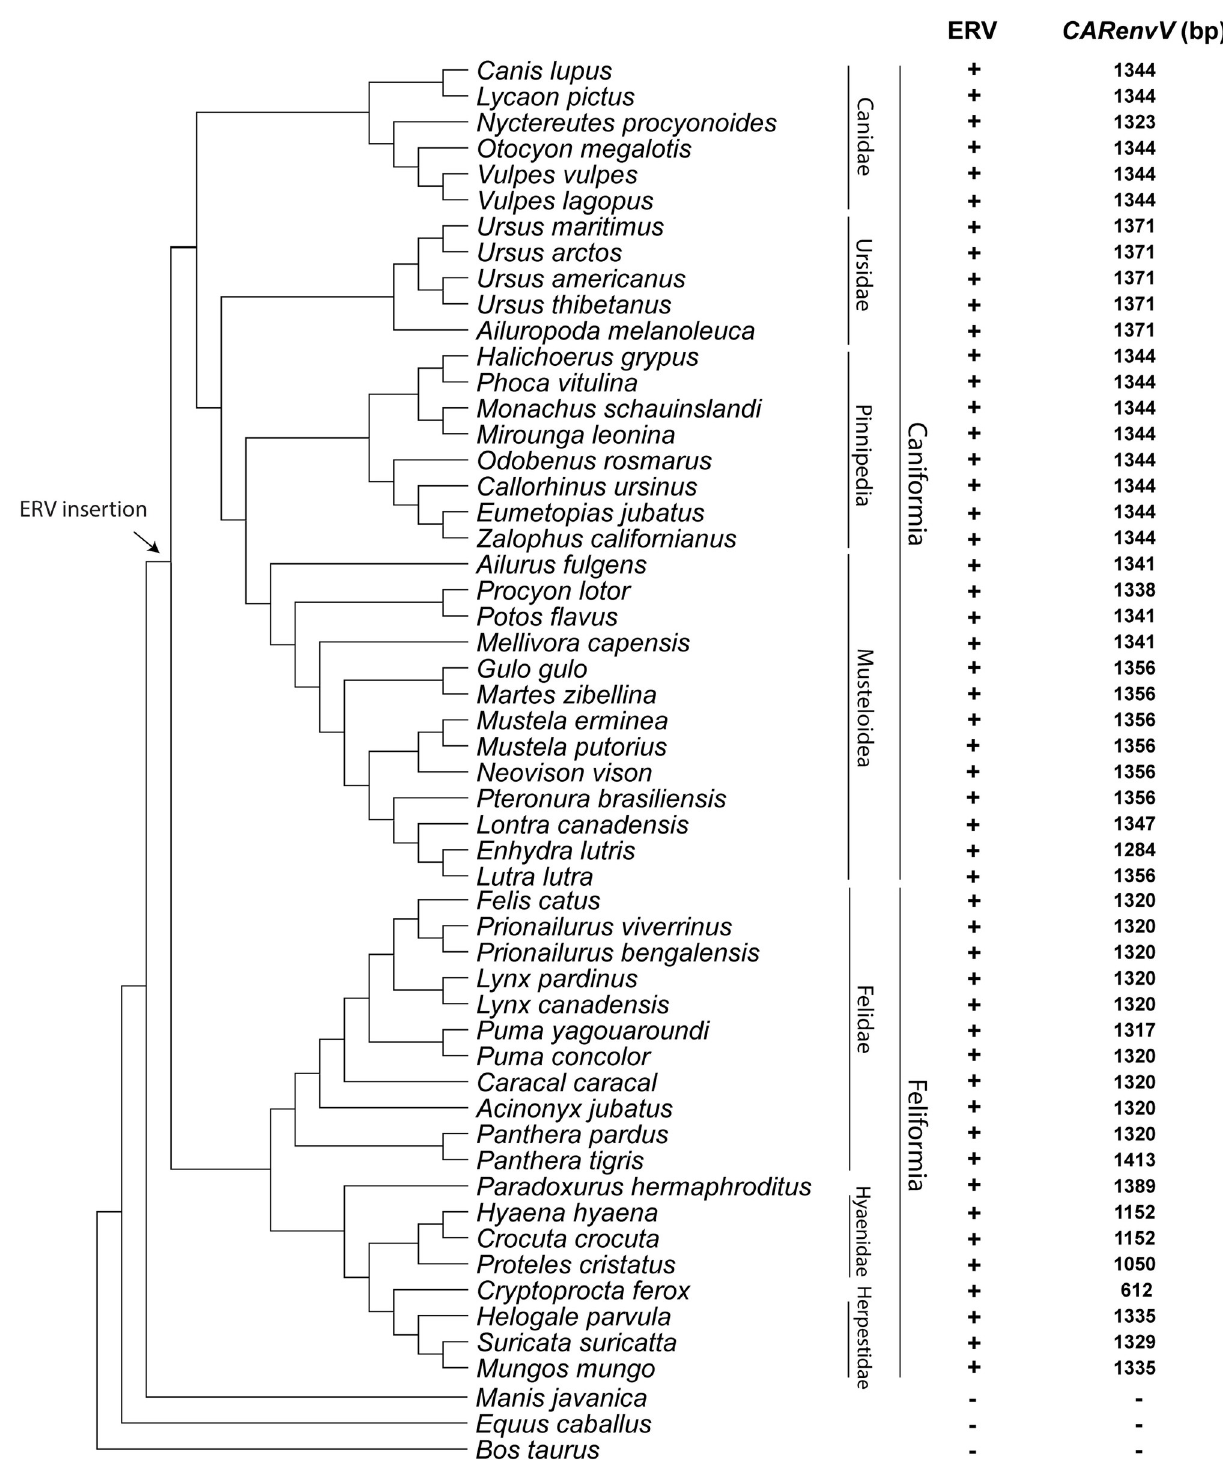
Fig 2. Conservation of CARenvV ORF in the lineages of Carnivora. A cladogram illustrates the evolutionary relationships of species with assembled genomes in the order Carnivora along with three species from sister orders of Carnivora. The tree was generated with TimeTree [82]. Suborder and family classifications are shown on the right. + indicates the presence and - indicates the absence of ERV orthologs that contain CARenvV as identified via BLAST searches of each genome assembly. The size of the CARenvV ORF found in the orthologous location at each genome assembly is indicated. An arrow marks the likely insertion and fixation of the ERV that contains CARenvV , based on the orthology analysis.